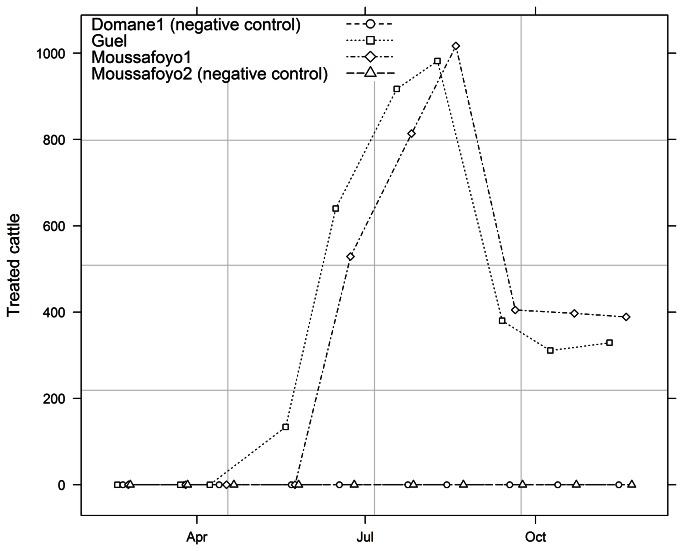
Monthly number of treated cattle at the four study sites for the impact assessment of footbath insecticide treatment on tsetse apparent density in Chad.Points were drawn at the dates corresponding to the visits.